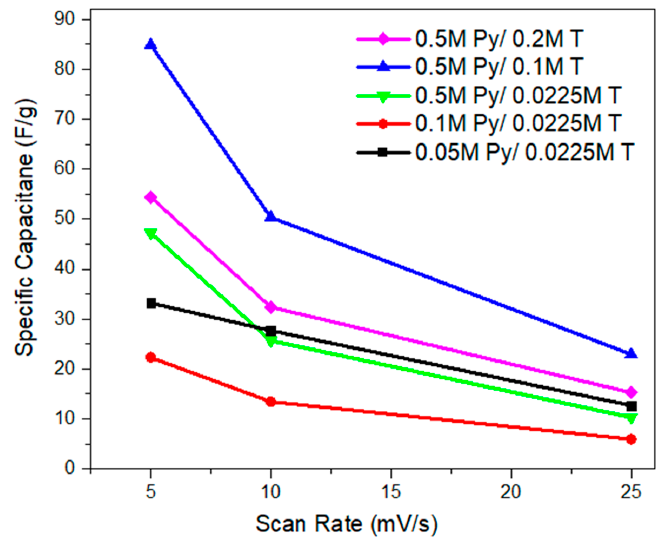
Figure 5. Summary of specific capacitance at each scan rate calculated from CV at 5, 10, and 25 mV/s.